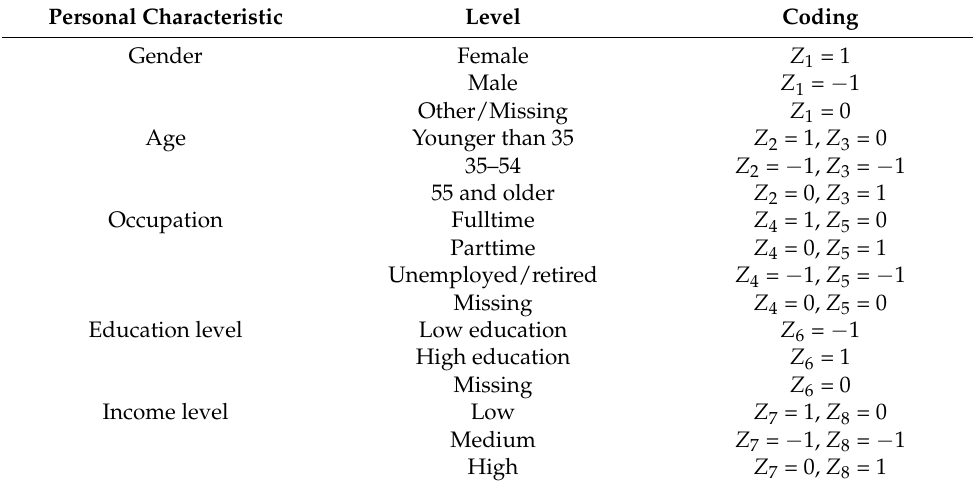
Table 3. Coding of personal